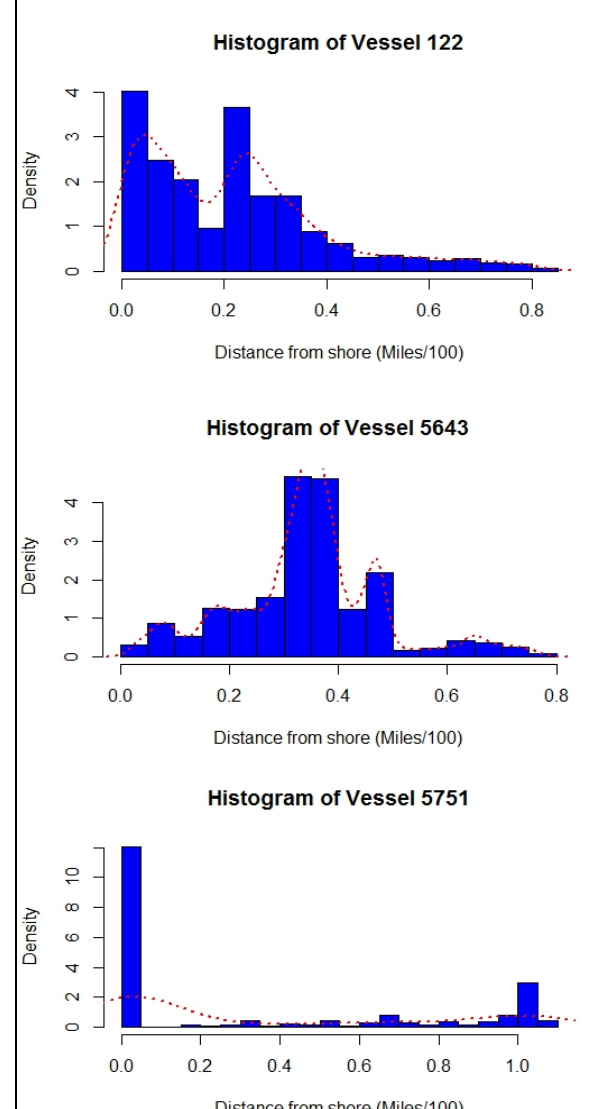
Figure 4 . Acceleration Threshold (SD*3)